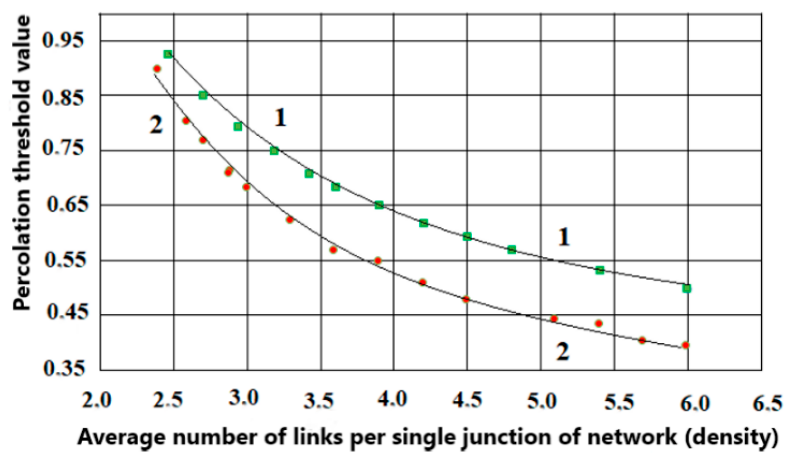
Figure 5. Dependency of values percolation threshold values of planar accidental networks on network density (curve 1—junction task, curve 2—link task).